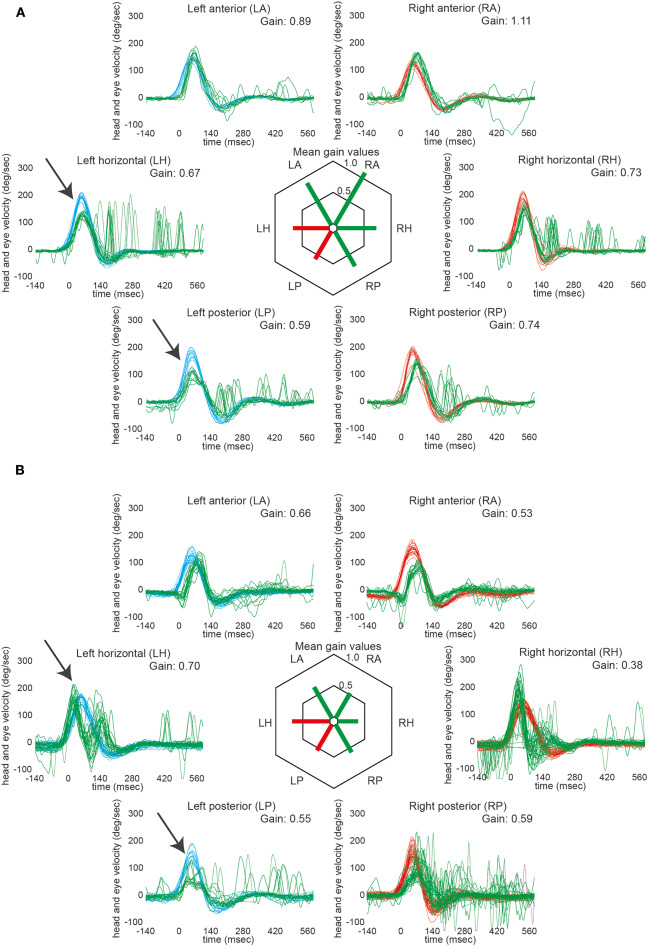
VHIT in those two patients that showed ipsilesionally impaired aVOR responses (#15 and 16). Note that both patients had ischemic lesions located at the rostral level of the dorsolateral medulla oblongata. In the left panel (A, #15), responses of the left horizontal and the left posterior semicircular canal were rated as impaired by the two reviewers (indicated by arrows). The mild reduction in gain of the right horizontal canal (being accompanied by catch-up saccades) was considered to be a compensatory down-regulation of the non-affected side. In the right panel (B, #16), again responses of the left horizontal and the left posterior semicircular canal were considered to be impaired by the two reviewers (indicated by arrows). Note that the eye traces are lagging the head traces in both anterior canals; thus, the calculated reduction in gain is most likely an artifact (this is also supported by the lack of catch-up saccades). In the right horizontal semicircular canal, the initial eye velocity traces are overshooting and then stop early (not showing consistent catch-up saccades); thus, the reduced gain (0.38) was considered an artifact. For the right posterior canal, the gain is slightly reduced and there are early catch-up saccades. This canal was rated as being overall slightly impaired due to the gain reduction and the presence of catch-up saccades. In both panels, eye velocity traces (in green) and head velocity traces (in red for assessing the right vestibular organ and in blue for assessing the left vestibular organ) are plotted against time for each SCC (20 trials per canal recorded). Note that eye velocity traces were inverted for better visualization and comparison with the head velocity traces. In the center of both panels, average gains are provided for all six semicircular canals. Whereas, canals with overall normal function were plotted in green, those with impaired function were illustrated in red.